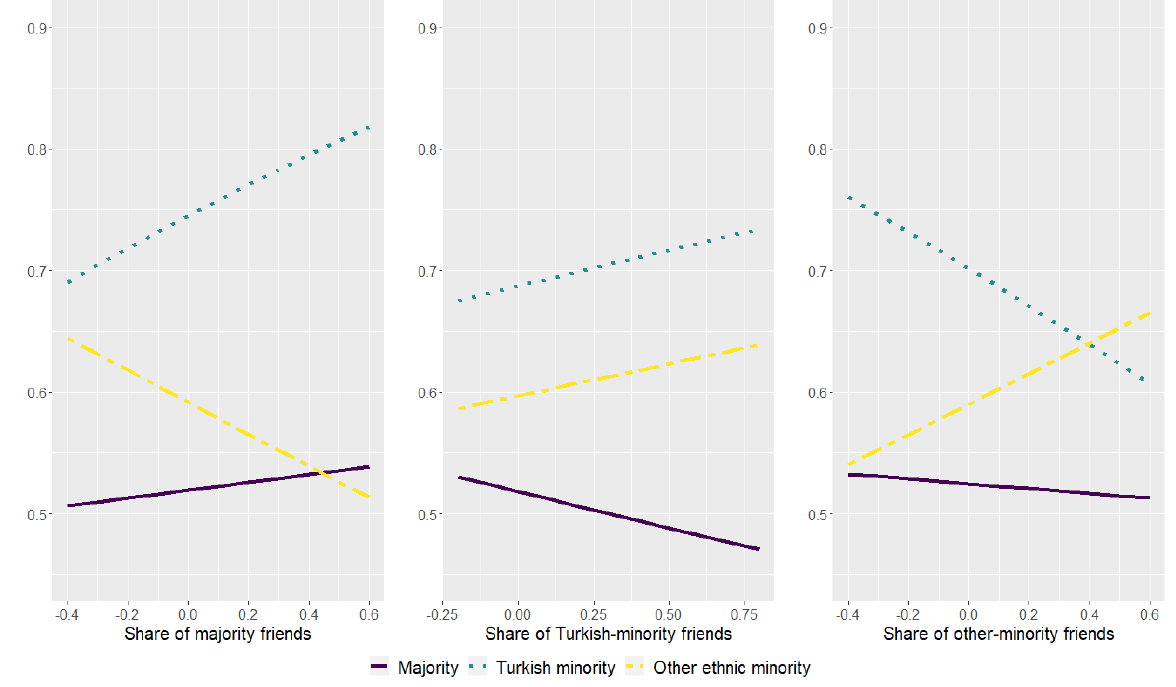
Figure 2: The effect of friends’ ethnic background on educational expectations. Notes: Average marginal effects from multilevel mixed-effects ordinal logistic regressions (the full results are provided in Table C2 in Appendix C of the online supplement). Sources: CILS4EU, authors’